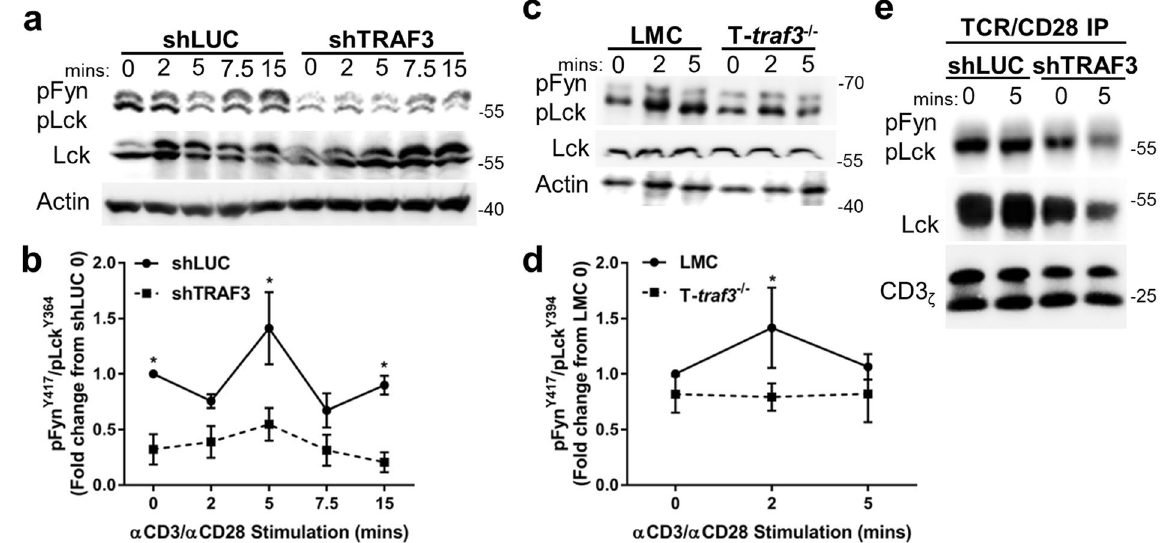
Figure 1. Requirement for TRAF3 in Src kinase activation by the TCR complex. T cells were stimulated via CD3/CD28 for indicated times. Whole cell lysates were prepared from HuT28.11 subclones shLUC or shTRAF3 ( a ), or primary mouse splenic T cells from LMC or T- traf3 − / − mice ( d ) as described in Methods. Western blot analysis was performed to detect the indicated proteins. Expression levels of pFyn Y417 /pLck Y394 , detected by anti- pSrc Y416 Ab ( b and d ) were calculated as: (pLck/Actin)/(Lck/Actin) = pLck Relative expression level (REL). Fold change was then determined based upon the obtained expression levels, as follows. (pLck REL)/(pLck REL of control time point 0) = pLck Fold change. Data from at least 3 independent experiments were pooled and the mean values + SEM are shown. A 2-way ANOVA was performed to establish statistical significance; * P < 0.05. T- traf3 − / − time point 7.5 is trending towards significance with p = 0.0597. ( e ) shLUC and shTRAF3 T cells were stimulated as described above. Immunoprecipitation of the TCR (CD3)/CD28 complex was performed on the whole cell lysates. The relative amount of pLck Y394 and total Lck association with the TCR/CD28 complex was analyzed by Western blot and blots were cropped to focus upon the specific proteins indicated. Full-length blots are presented in Suppl. Fig. S5. Data are representative of 3 individual